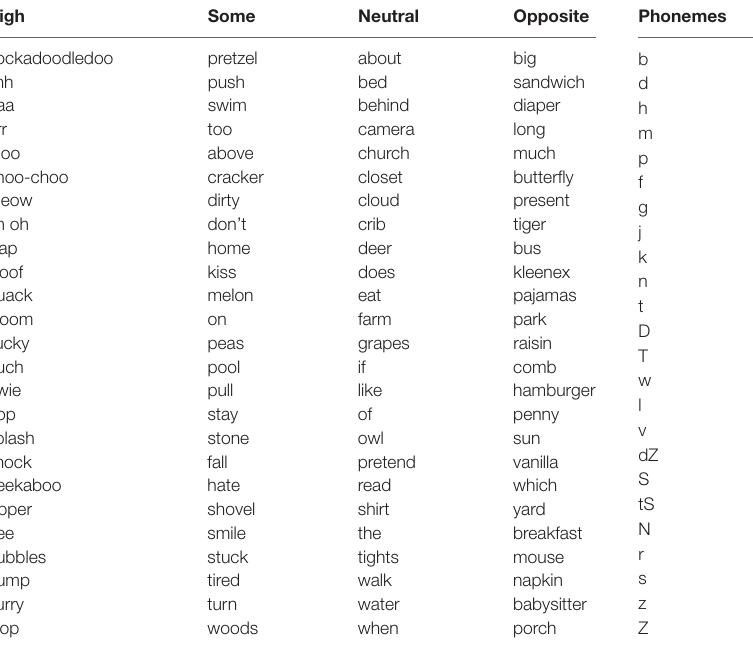
TaBle 1 | Four groups of 26 words each differing in iconicity (the degree to which the sound of a word represents its meaning) as rated by 15 participants on a scale from − 5 to + 5.